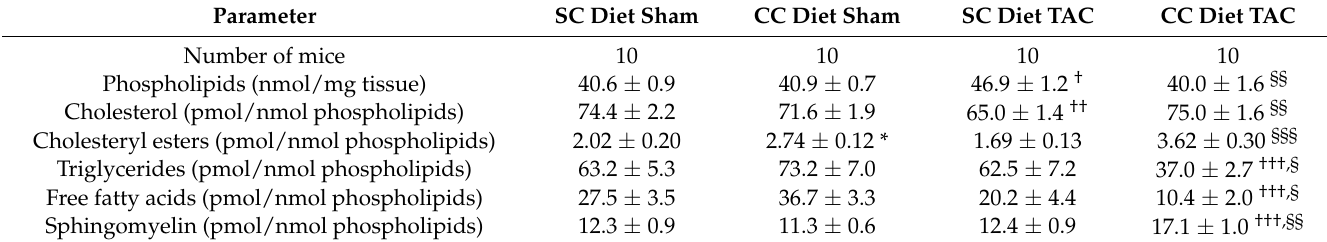
Table 6. Myocardial lipid levels eight weeks after sham operation or after TAC in C57BL/6 mice fed the SC diet or the CC